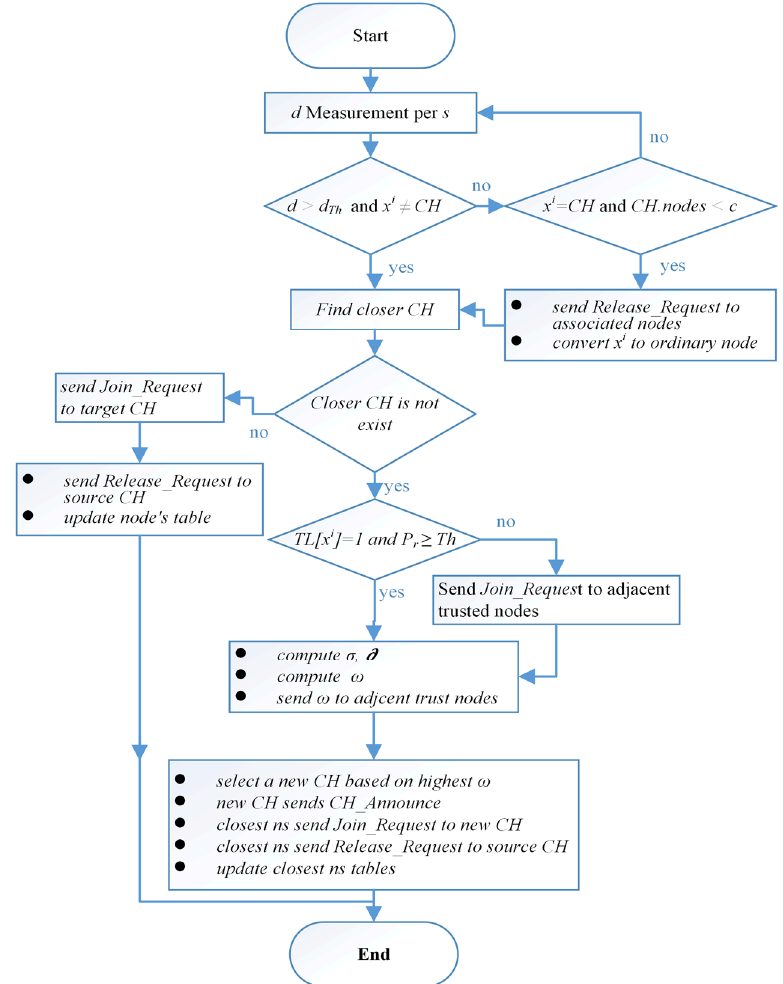
Figure 5. Trust-CH rotation process.